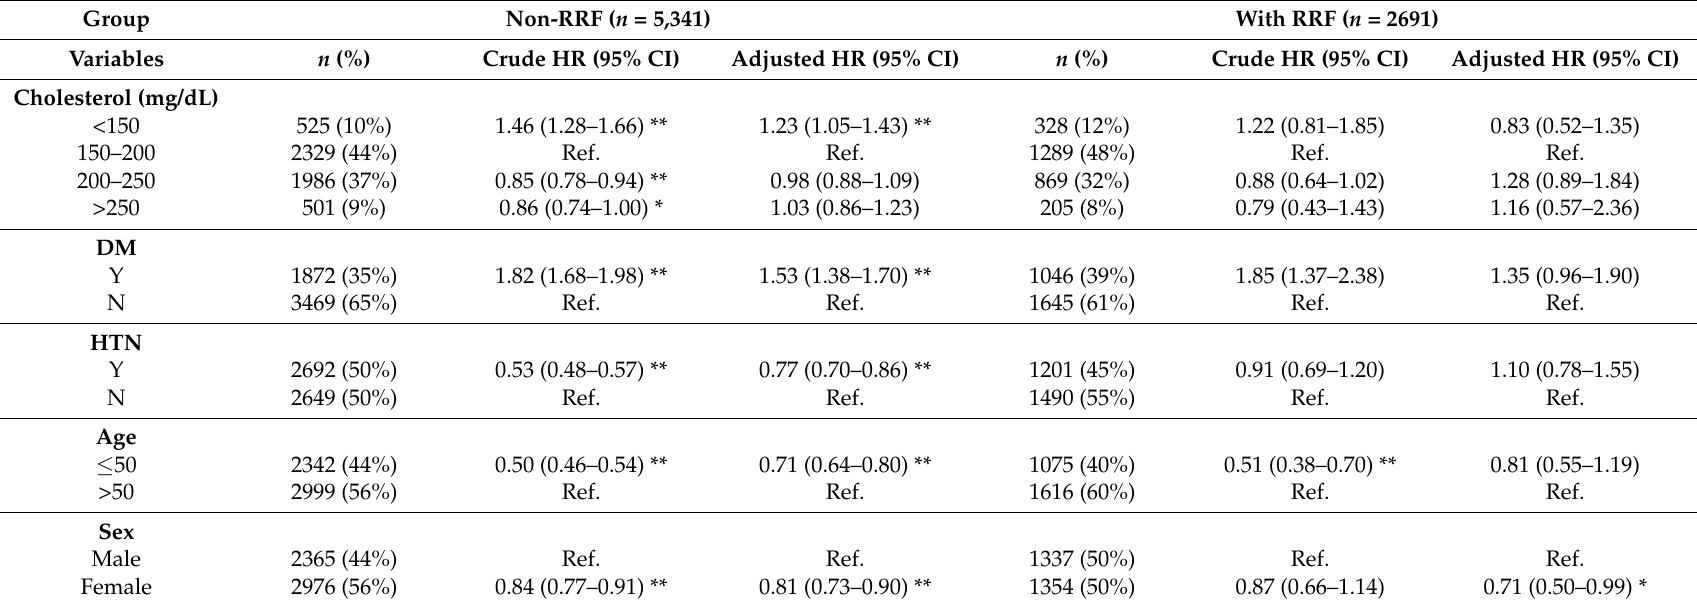
Table 3. Hazard ratio (HR) of mortality in subgroups and stratification according to RRF by cox regression